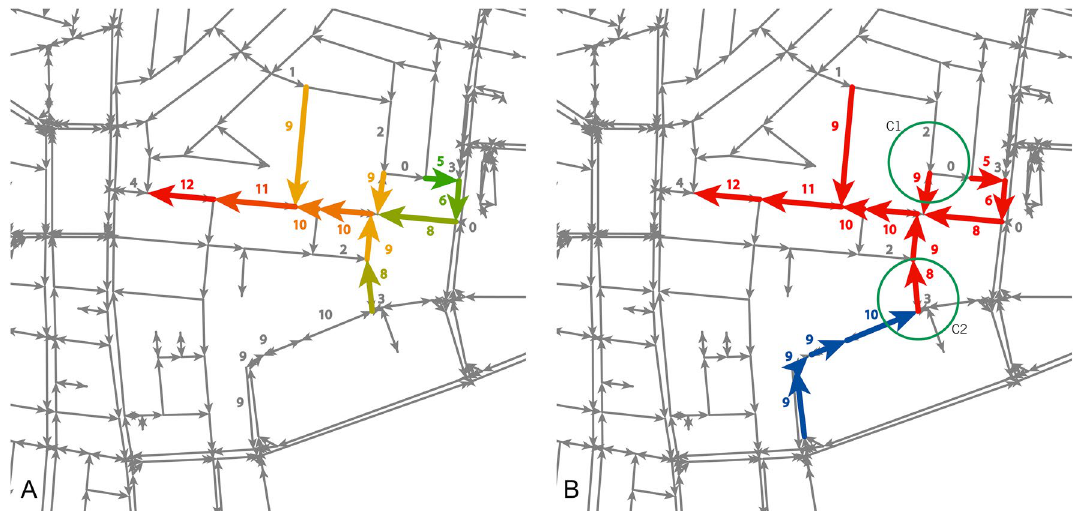
Figure 5. Clusters of JTs. The numbers represent the number of measurements each street segment was congested. ( A ) All the colored streets are part of one JT where the red street represents its trunk: its duration (12 successive measurements that represent 3 h) is the longest, which indicates it was the first street with traffic load in this JT. ( B ) Two JTs (represented by red and blue colors). The red JT does not include the street that has been loaded for 2 measurements, as the time gap between this street and its adjacent one is larger than the pre-defined threshold θ (see the upper green circle). The blue JT cannot be considered as part of the red JT, as the duration of its trunk is longer than that of its adjacent street in the red JT (see the lower green circle). When a bottleneck is released but the JT that follows it remains congested, the next street segment with the longest duration becomes the new trunk of the JT and carries the cost of the remaining branches of the